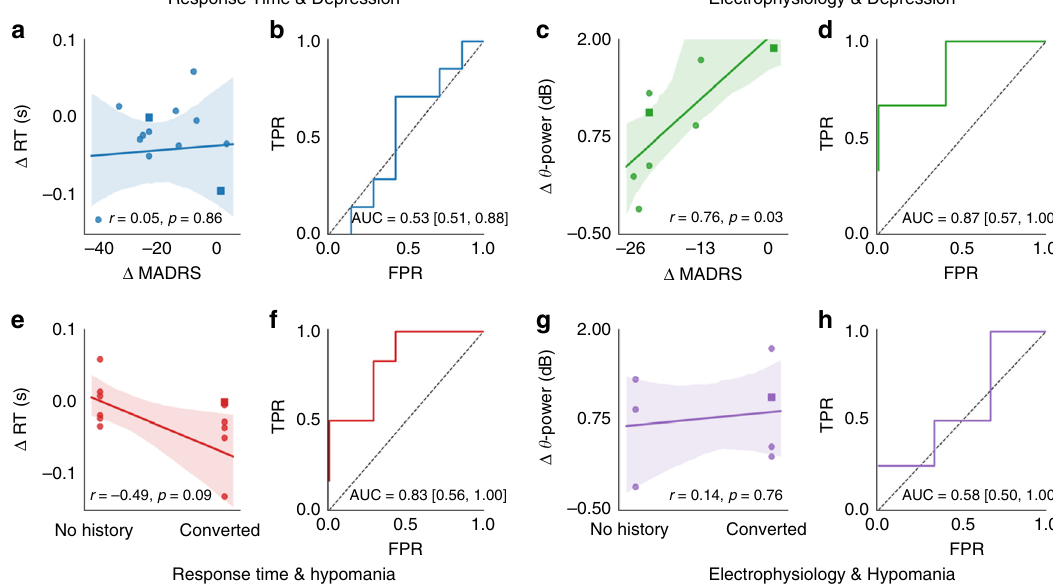
Fig. 5 Changes in ventrolateral PFC (VLPFC) theta power predict clinical outcomes. a , c , e , g Clinical outcomes vs. behavioral and neural changes. Panels ( a , c ) show change in Montgomery – Åsberg Depression Rating Scale (MADRS, where negative values indicate improvement); e , g show hypomania. Y axes are a , e the DBS-induced response time (RT) difference for each subject or c , g theta power difference during the period covered by the Fig. 3c cluster. Lines represent a robust linear regression. Circles represent subjects with primary diagnosis of MDD, squares represent subjects with primary diagnosis of OCD. Shaded areas are con fi dence bounds from 1000 bootstraps. “ r ” represents Pearson correlation, p -value via Fisher Z -transformation. b , d , f , h Receiver operating characteristic (ROC) curves for clinical response prediction. Con fi dence interval for area under the curve (AUC) is from 1000 bootstrap